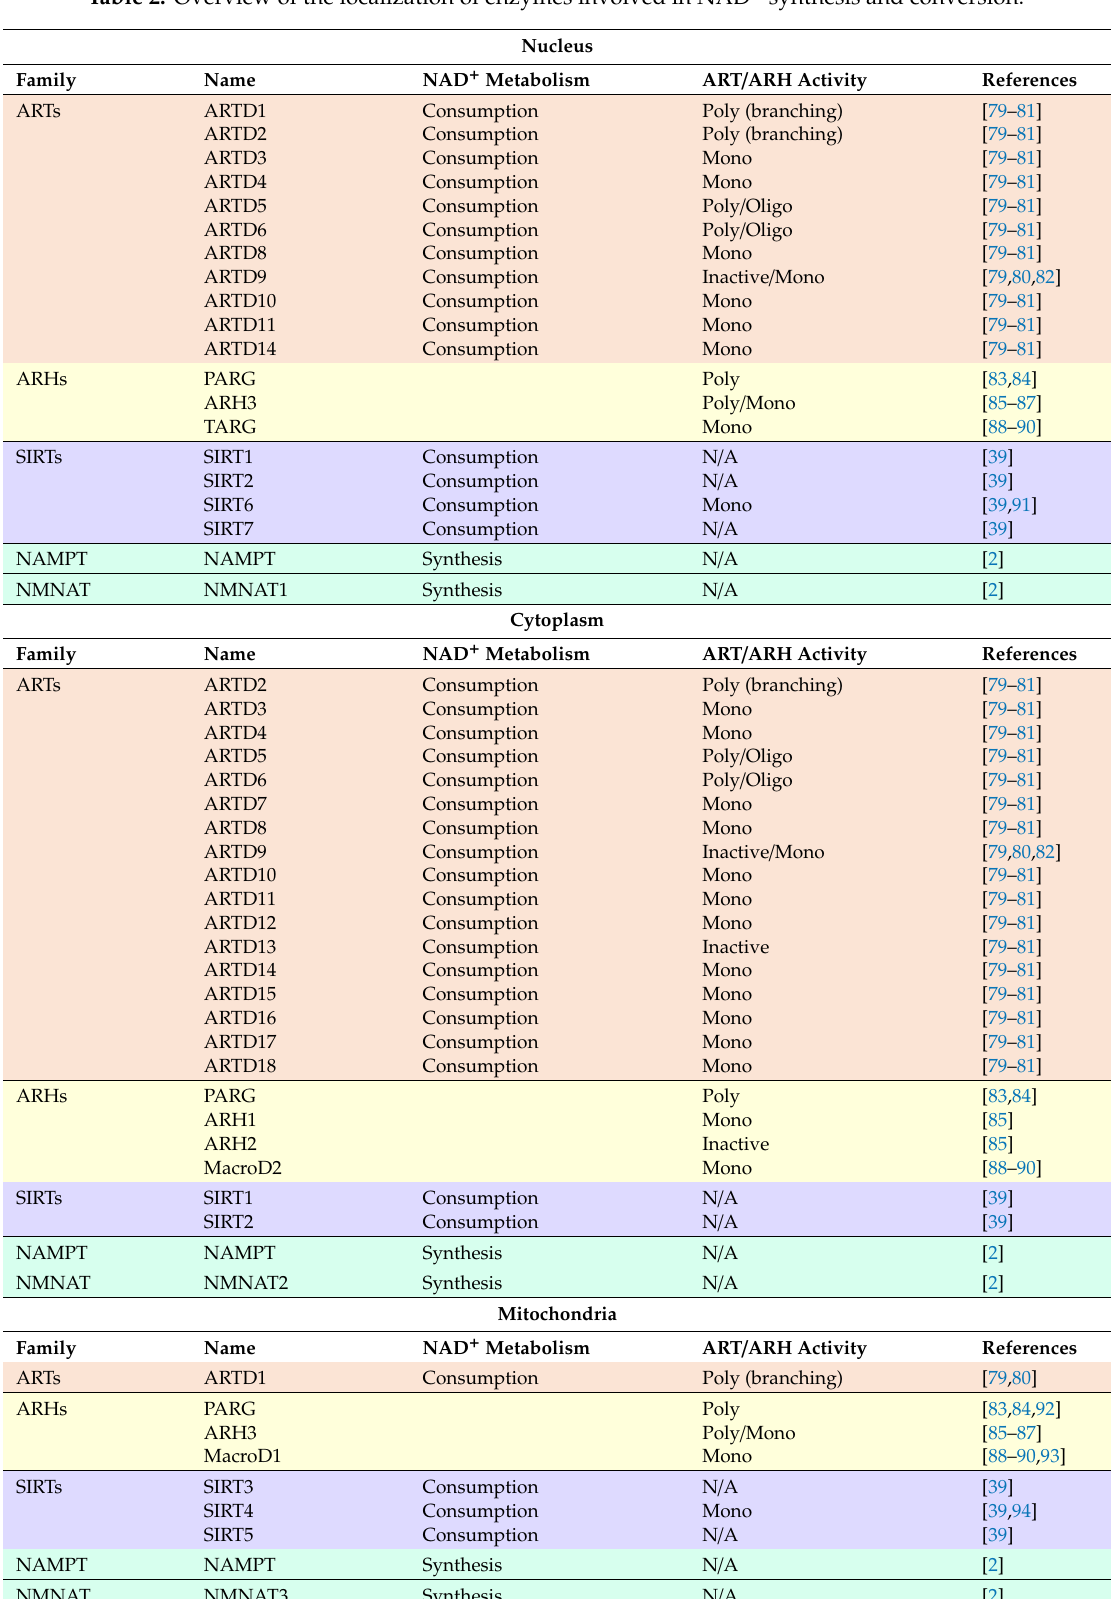
Table 2. Overview of the localization of enzymes involved in NAD + synthesis and